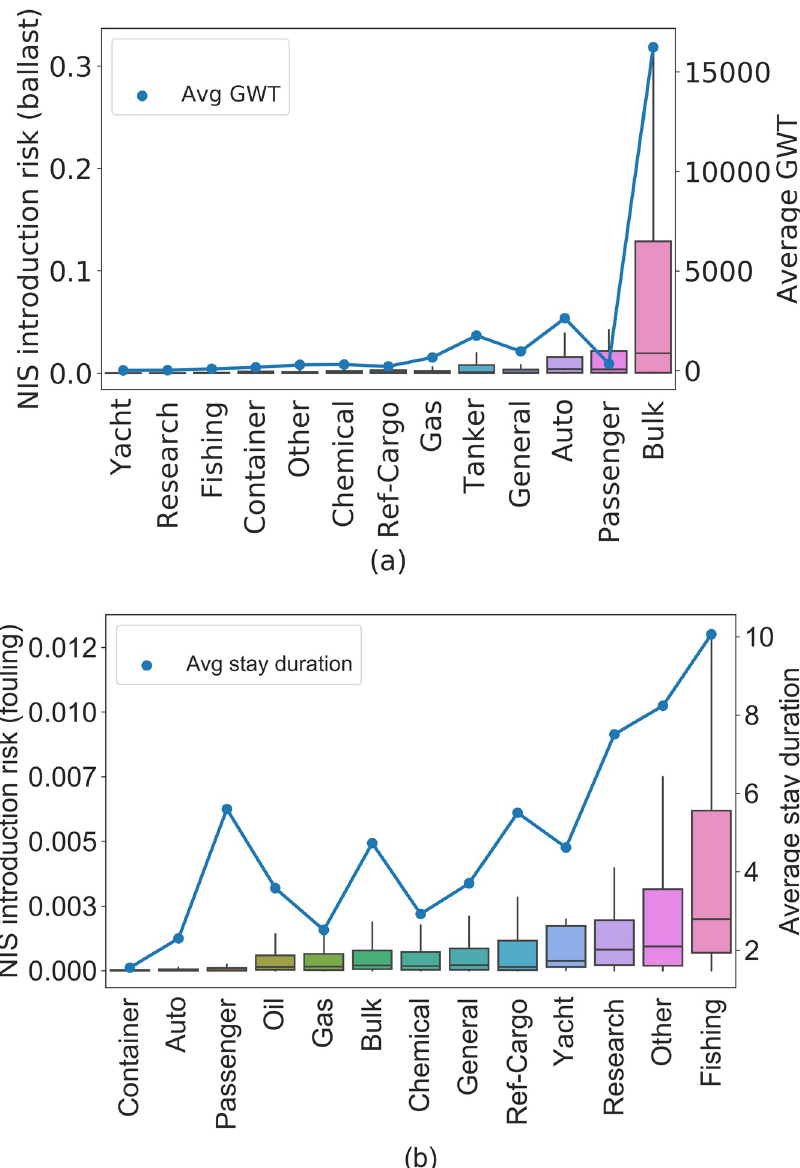
Fig 8. Box plots represent the NIS introduction risk for all voyages by different ship types for ballast water (a) and biofouling (b). For ballast water, GWT and for biofouling, duration of stay at port display the same pattern as the NIS introduction